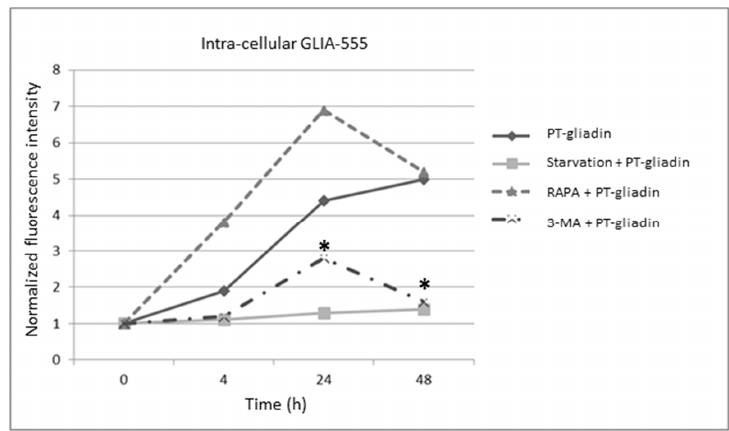
Figure 11. Intra-cellular fluorescent PT-gliadin (GLIA-555) content following autophagy modulation in Caco-2 cells. PT-gliadin was administered as fluorescent GLIA-555 (1 µg/µL) moieties and assayed